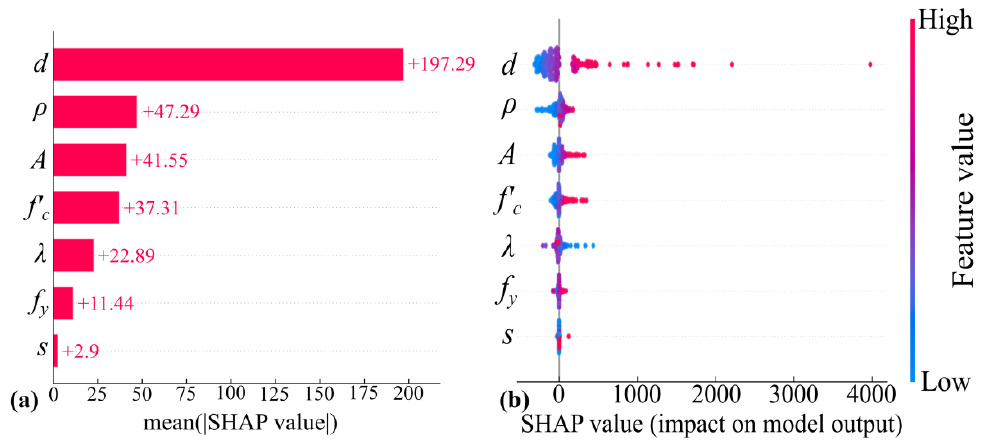
Figure 7. Global interpretation of punching shear resistance: ( a ) feature importance sorting; ( b ) SHAP value summary plot.